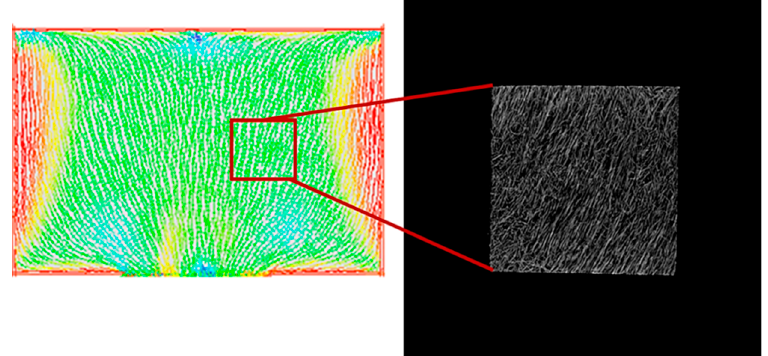
Figure 6. Comparison of moldflow CAE with Micro-CT image.